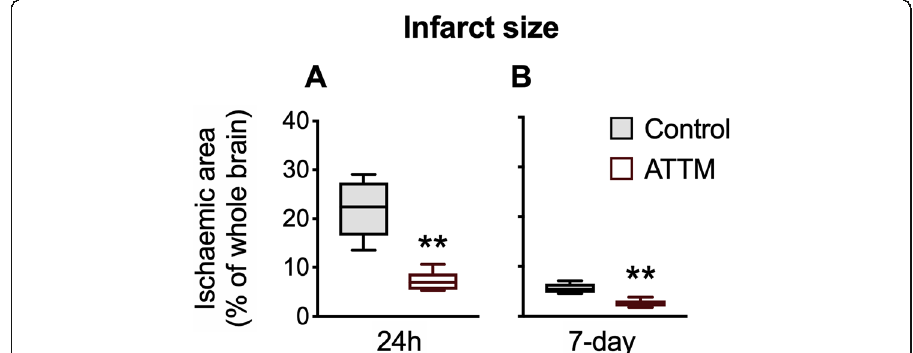
Fig. 3 Histological outcomes. Brain infarct size, determined at 24 h or 7 days post-reperfusion, is shown in panels a and b , respectively. n = 5 per group. ** p < 0.01 vs controls, unpaired T test